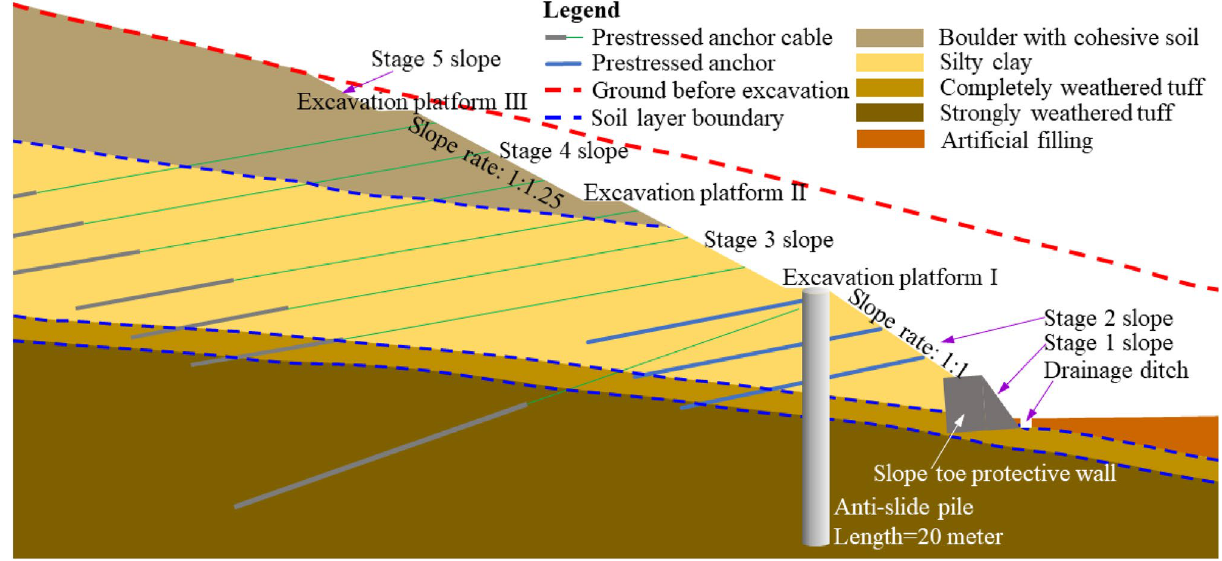
Figure 3. Typical geological cross-section and support measures during the slope construction.